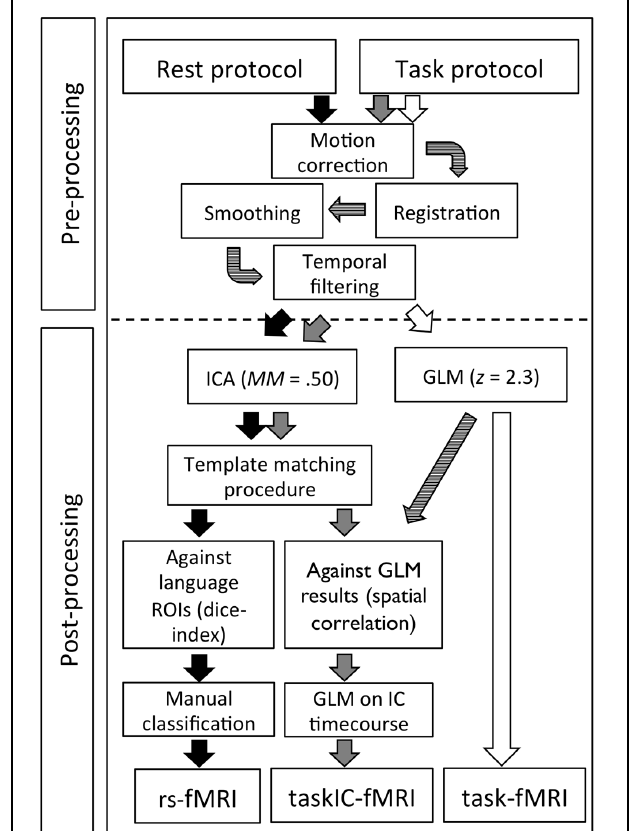
FIGURE 1 | Overview of the image pre-processing and post-processing steps for resting-state rs-fMRI, taskIC-fMRI and